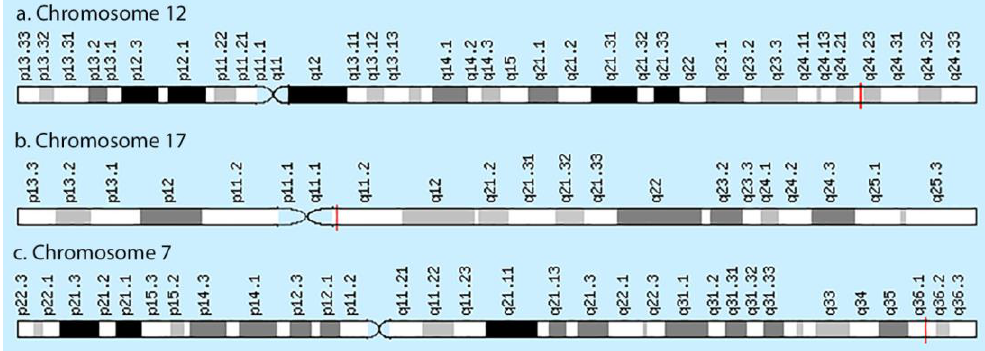
Figure 2. Localization of NOS1 ( a ), NOS2 ( b ), and NOS3 ( c ) genes.